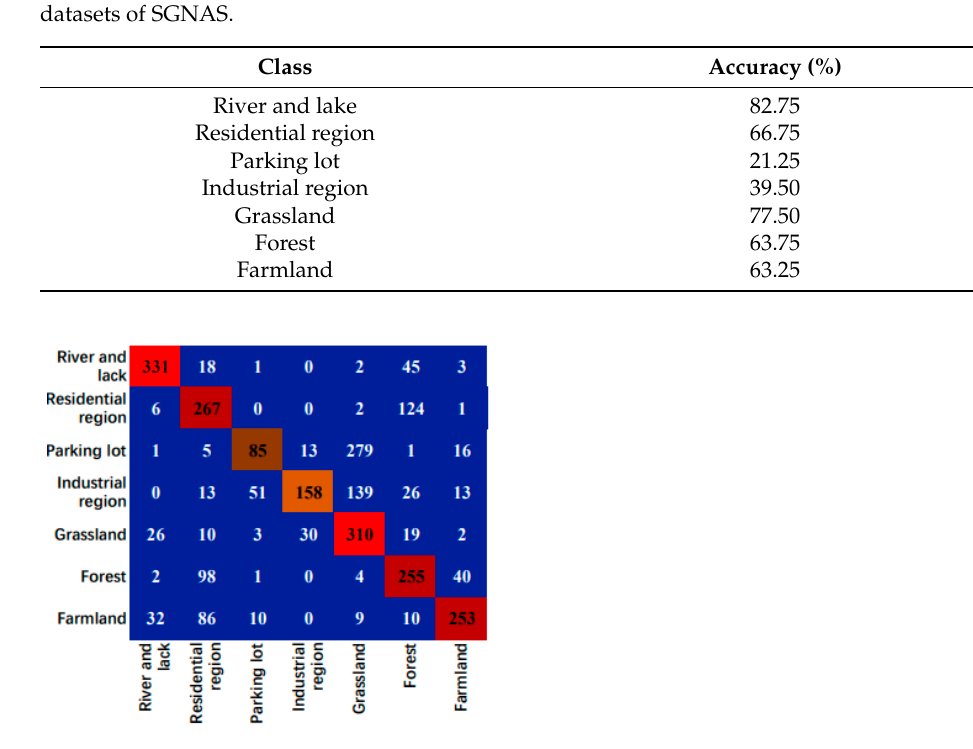
Figure 10. Confusion matrix of the cross-domain scene classification results for UCM → RSSCN7.